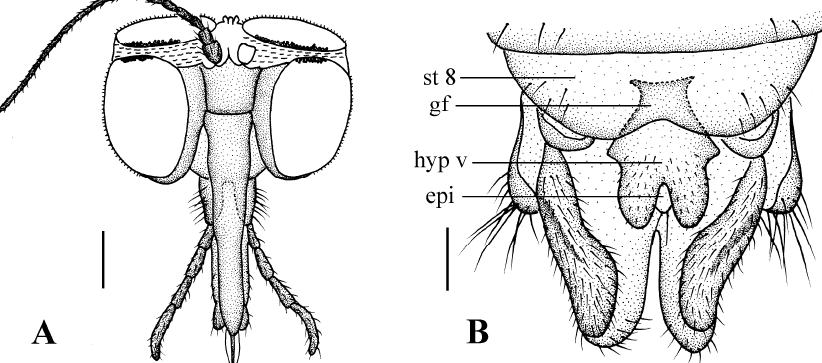
Figure 4. Blepharicera beishanica sp. nov. (female paratype). ( A ) female head, frontal view ( B ) female terminalia, ventral view. Scale bars: 0.25 mm ( A ), 0.1 mm ( B ). Abbreviations: epi = epiproct, gf = genital fork, hyp v = hypogynial valve, st 8 = eight sternite.